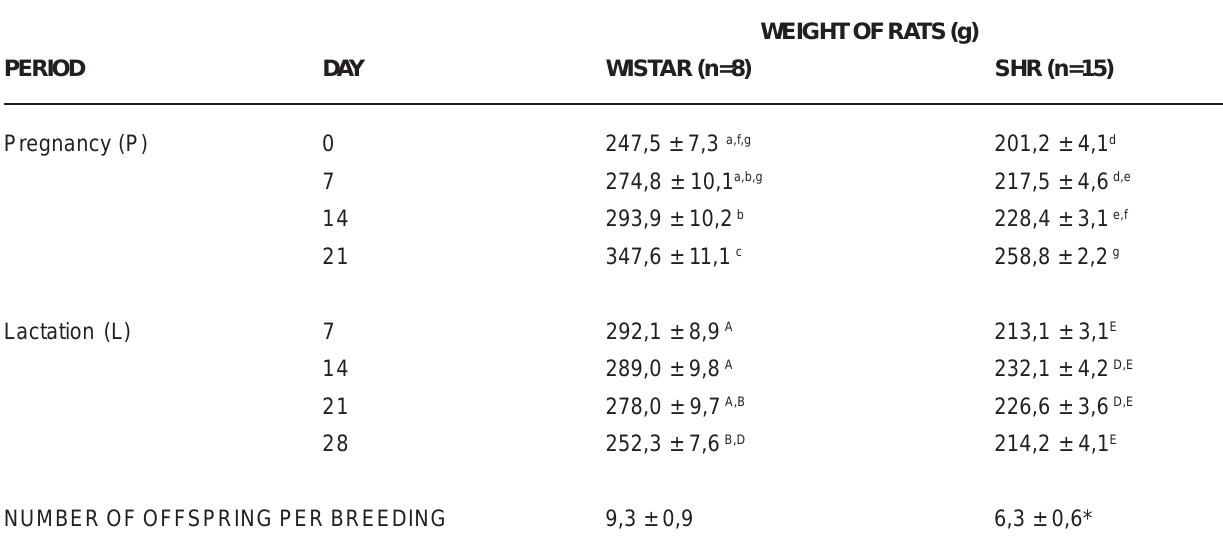
TABLE 1- Weight gain of Wistar rats and SHR rats during the days of pregnancy and lactation and number of offspring per